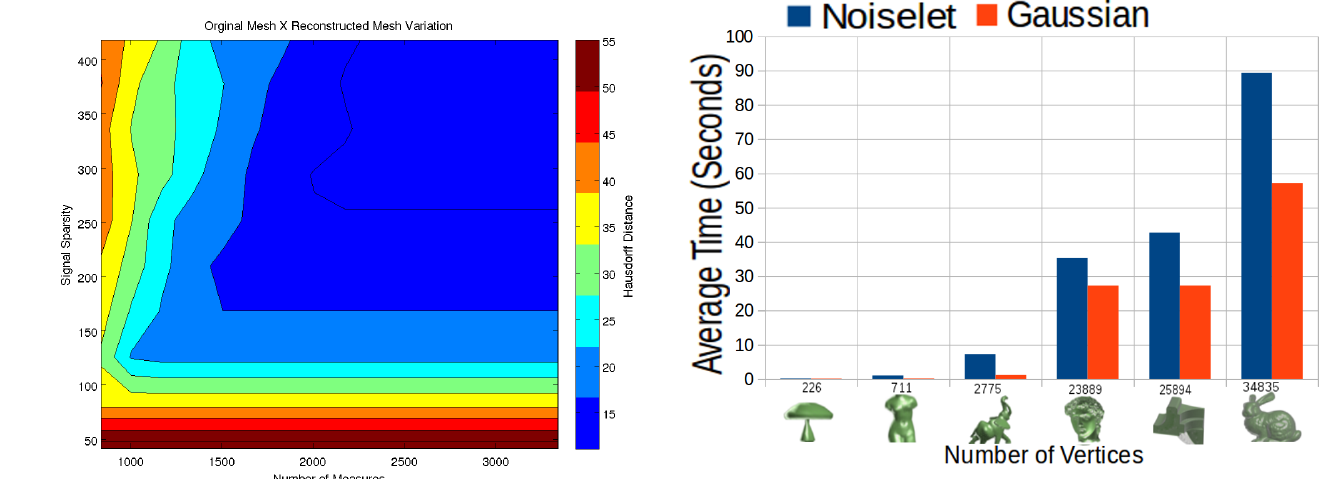
Figure 10: Average of processing times (in seconds ) for the meshes used in our